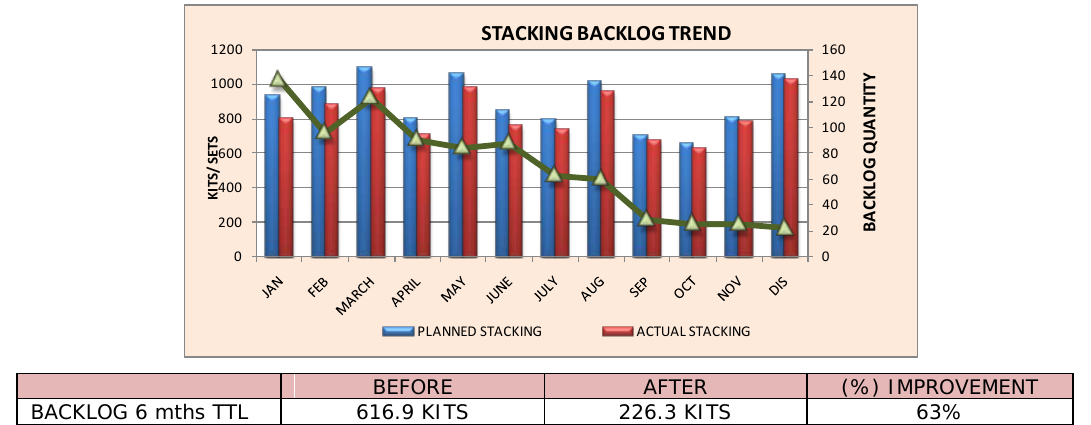
Figure 9B. “Percentage of improvement for stacking backlogs”.